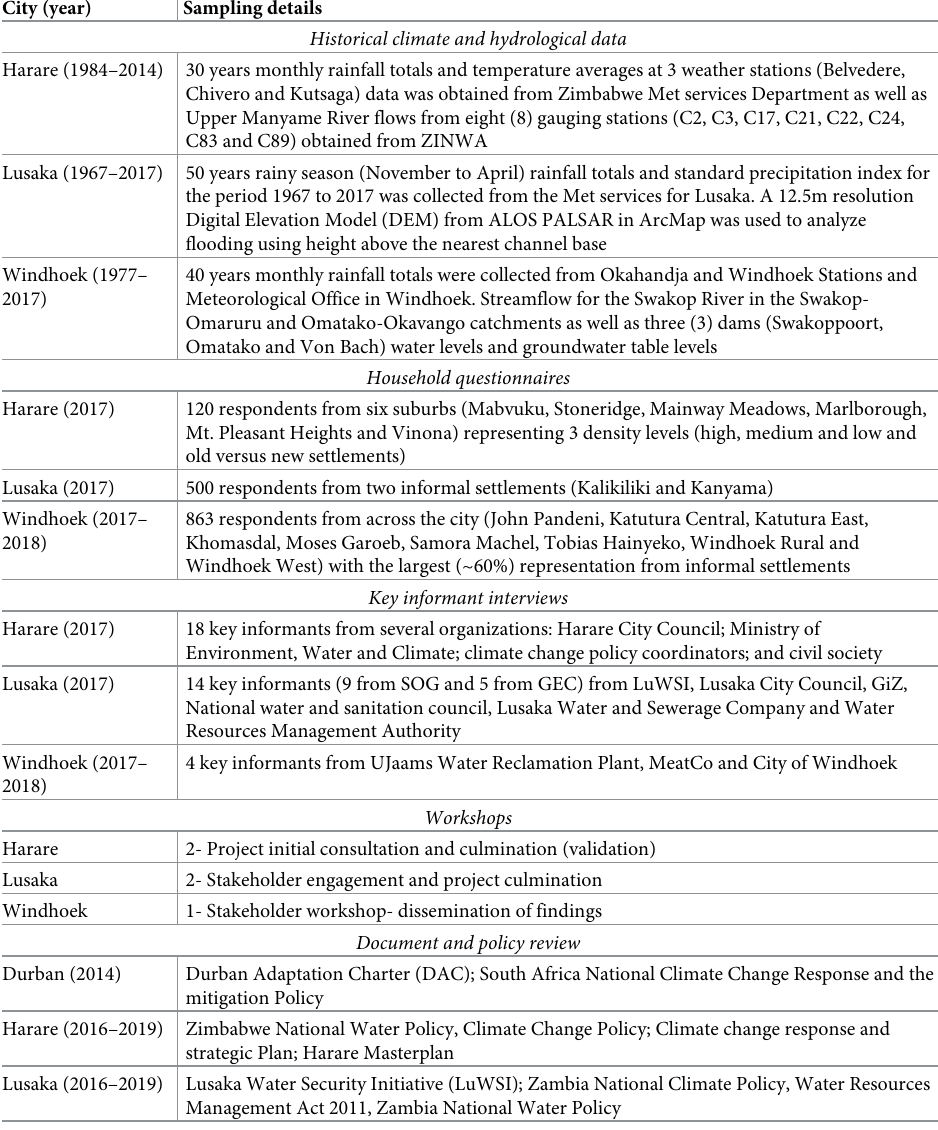
Table 1. Sources of information in the